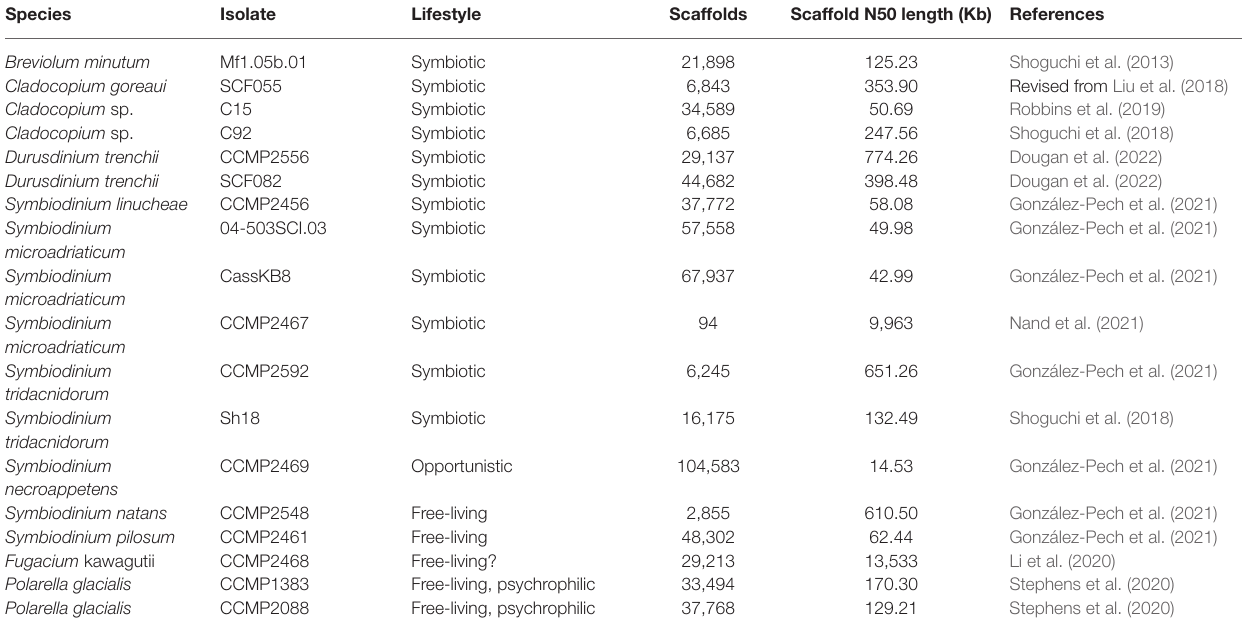
TABLE 1 | Genome data of the 18 dinoflagellate taxa (Order Suessiales) used in this study. Species Isolate Lifestyle